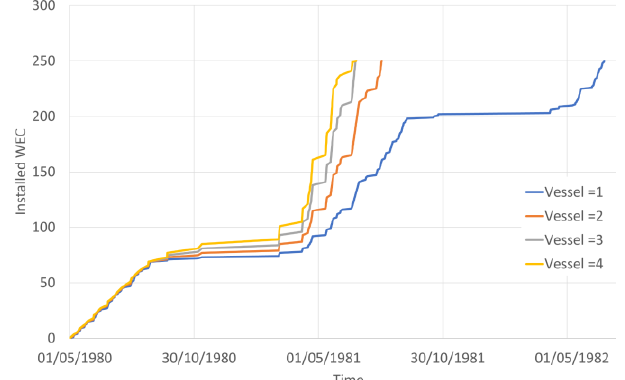
Fig. 16. Time series of WECs installed, where connection/ disconnection time is 1 hr and 3 assembly teams, and 2 onshore teams are